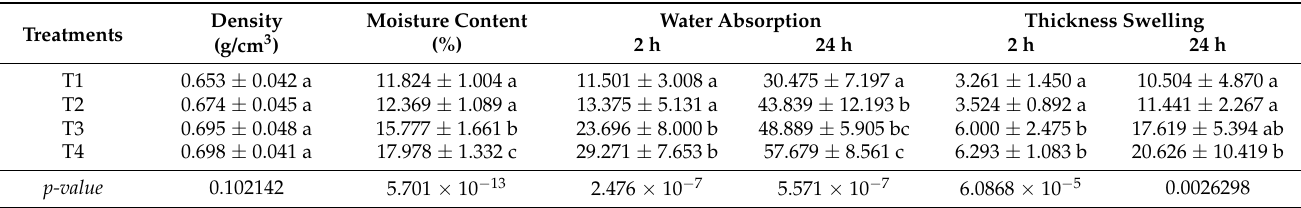
Table 3. Results of physical properties analyzed for panels with 10 vol.% of resin.